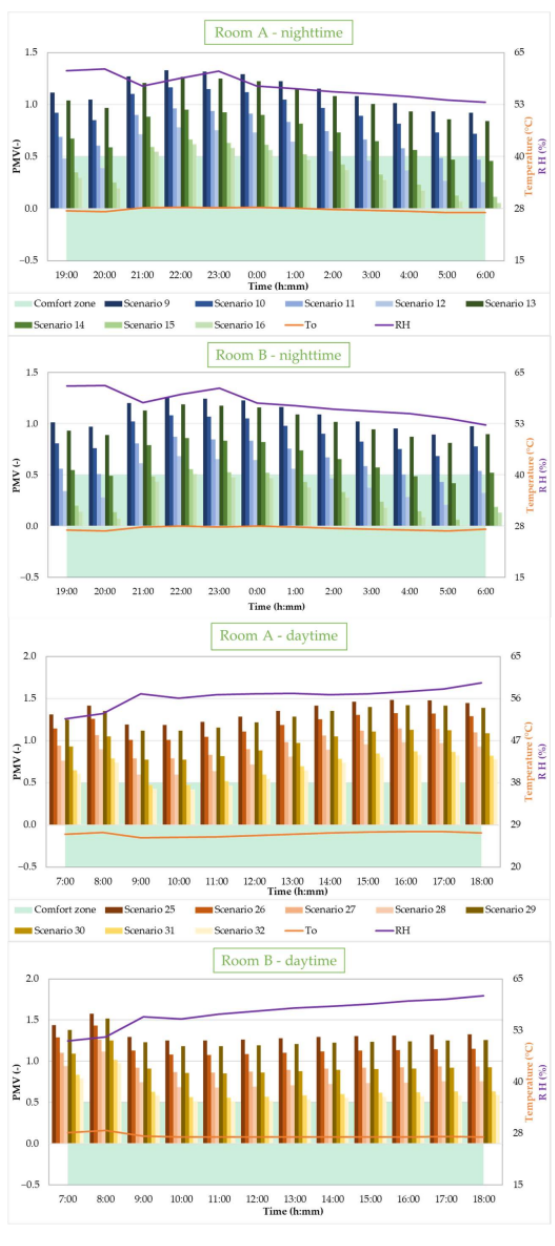
Figure 11. Hourly operative temperature, relative humidity, and PMV in rooms A and B with a bedridden patient: different scenarios in the summer